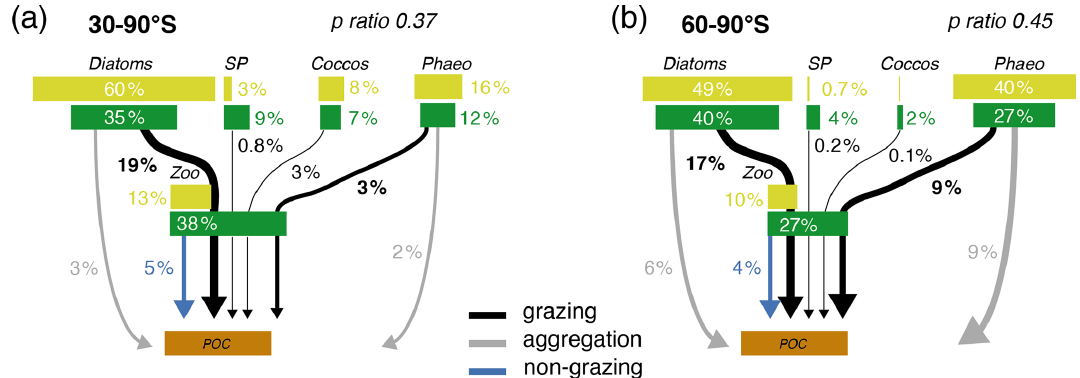
Figure 6. Pathways of particulate organic carbon (POC) formation in the Baseline simulation of ROMS-BEC averaged annually over (a) 30–90 ◦ S and (b) 60–90 ◦ S. The results for the Ross Sea are comparable to those between 60–90 ◦ S (see Fig. S11). The green and yellow boxes show the relative contribution ( % ) of Phaeocystis , diatoms, coccolithophores, small phytoplankton (SP), and zooplankton (Zoo) to the combined phytoplankton and zooplankton biomass (green) and total POC production (yellow) in the top 100m, respectively. The arrows denote the relative contribution of the different POC production pathways associated with each PFT (black is grazing by zooplankton, gray is aggregation, and blue is non-grazing mortality) given as percentage of total NPP in the top 100m. Numbers are printed if ≥ 0 . 1% and rounded to the nearest integer if > 1%. The sum of all arrows gives the POC production efficiency, i.e., the fraction of NPP which is converted into sinking POC upon biomass loss ( p ratio). Note that diazotrophs are not included in this figure due to their minor contribution to NPP in the model